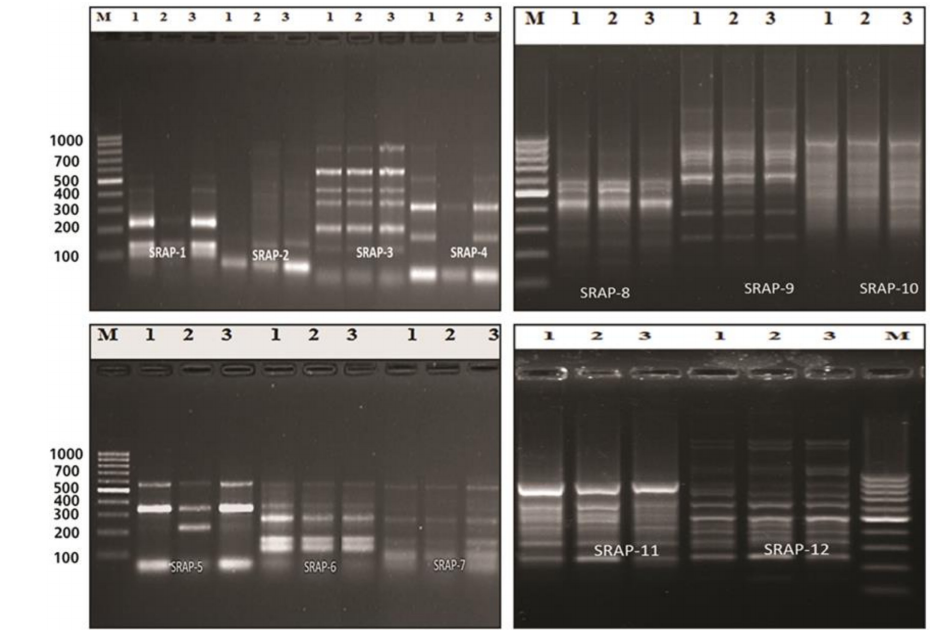
Figure 3. PCR amplification using SRAP primer combinations of control, BRs at 10 − 8 M, and CHT 200 mg / L (1–3), M (DNA ladder 100 bp) of Solidago canadensis cv. Tara